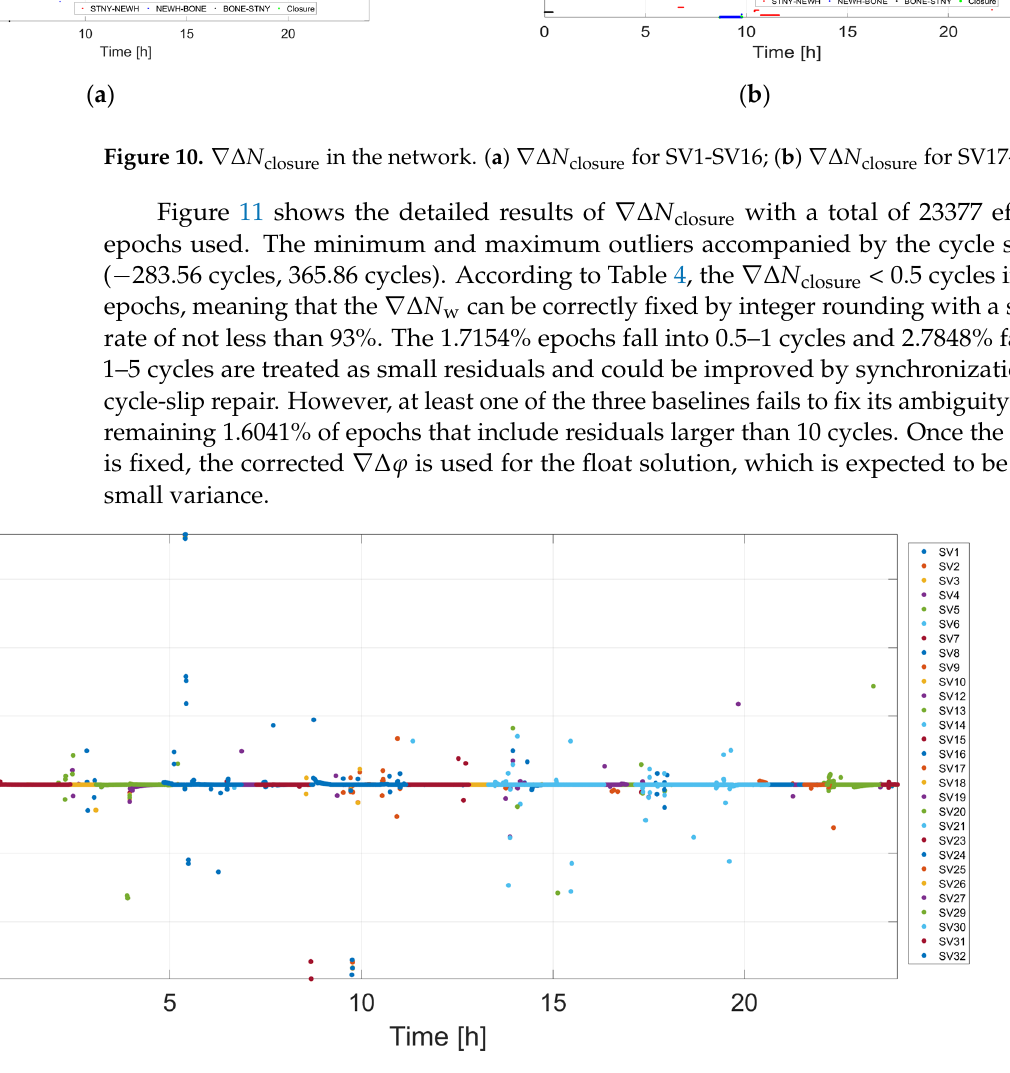
Figure 11. Ambiguity closure residual in the network. Table 4. The statistics of ∇ ∆ N closure .